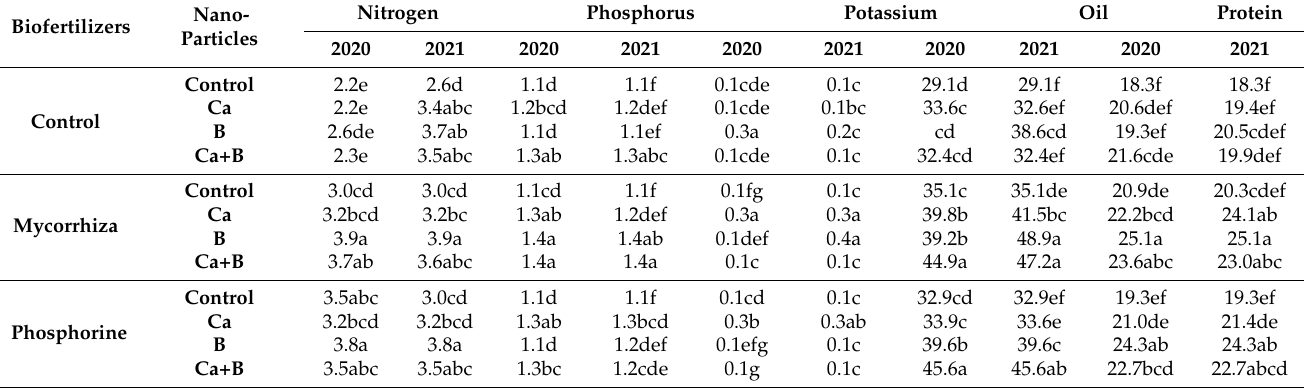
Table 4. Effects of interaction between biofertilizer and nanoparticle treatments on peanut seed biochemical traits across two successive seasons (2020 and